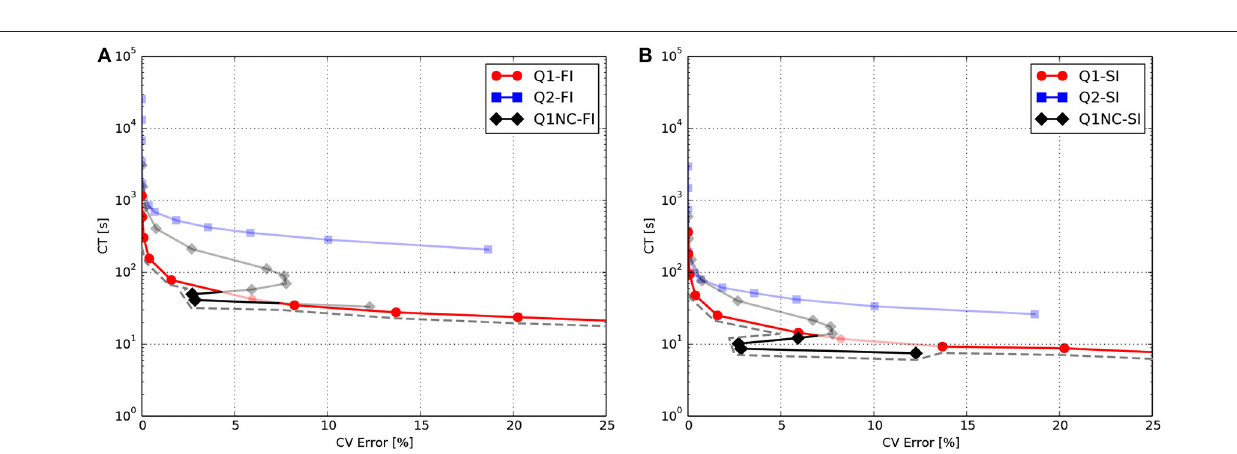
FIGURE 1 | CV tests for plane-waves propagating on a 3D bar for FI and SI schemes on different element formulations. (A) Convergence study of CV as a function of the mesh size h . (B) Computational effort in terms of CT as a function of h .